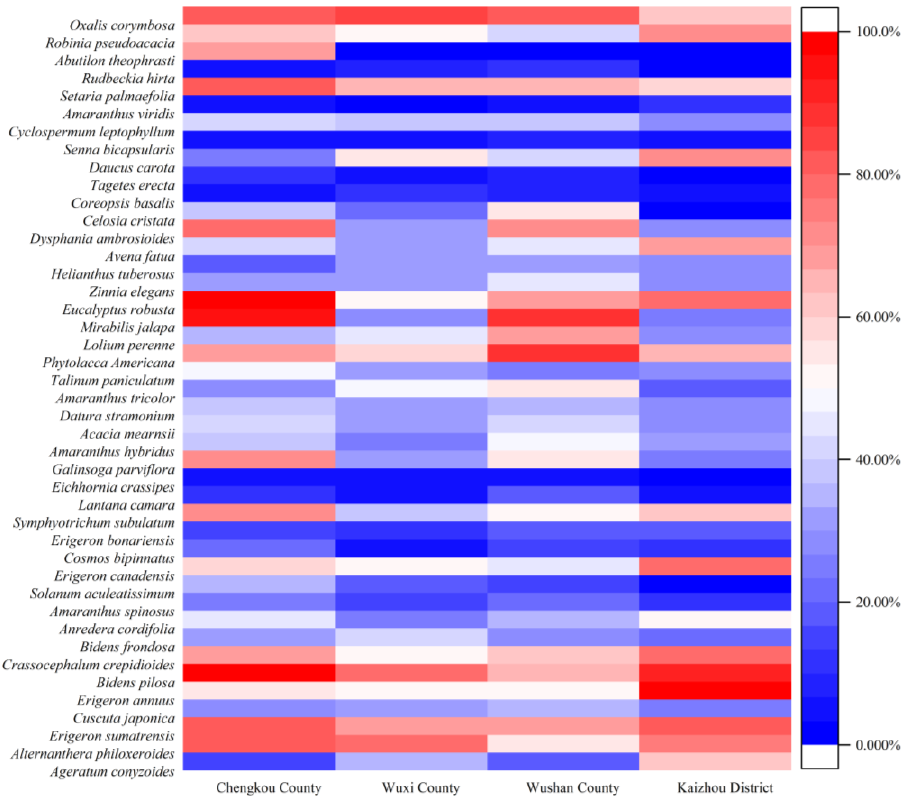
Figure 9. Distribution frequency of high- and medium-risk IAS in villages and towns. (Different colors and shades in the picture represent different distribution frequencies of IAS in various districts and counties.)